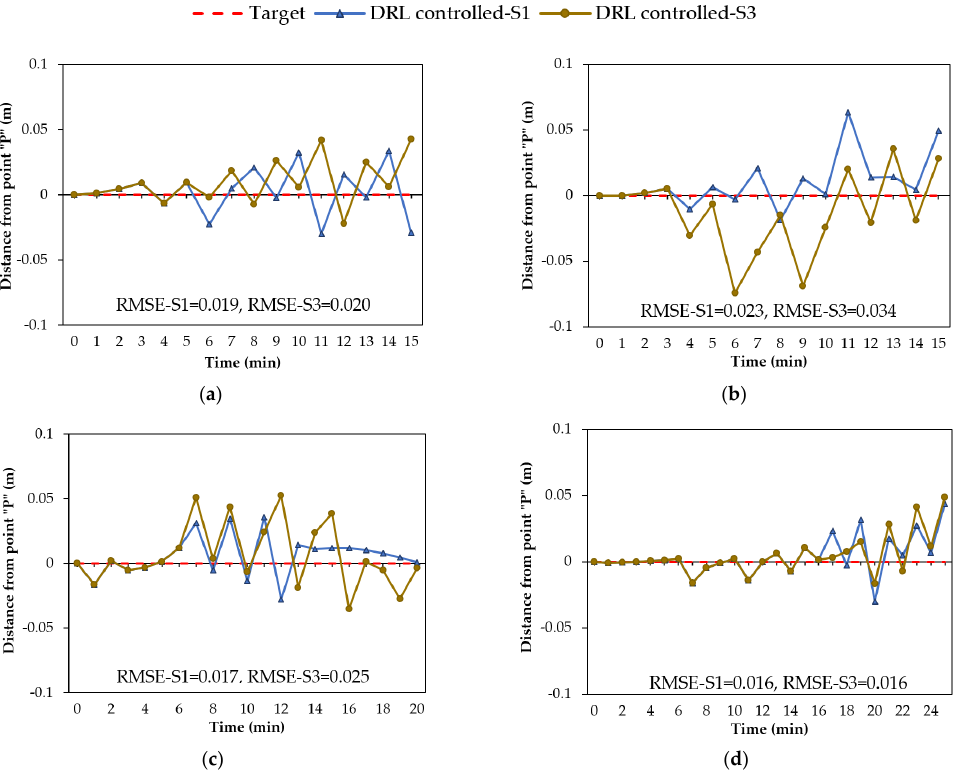
Figure 9. DRL-controlled groundwater with one and three observations (S1 and S3) from the envi- ronment during rainfall events: ( a ) 15-min-constant; ( b ) 15-min-normal; ( c ) 20-min-descending; ( d ) 25-min-ascending. vironment during rainfall events: ( a ) 15‑min‑constant; ( b ) 15‑min‑normal; ( c ) 20‑min‑descending; ( d )